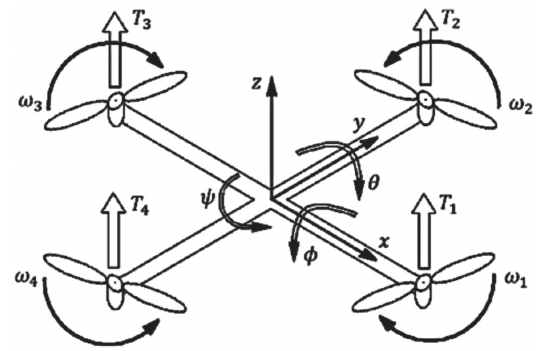
Fig. 6. Vector analysis of the